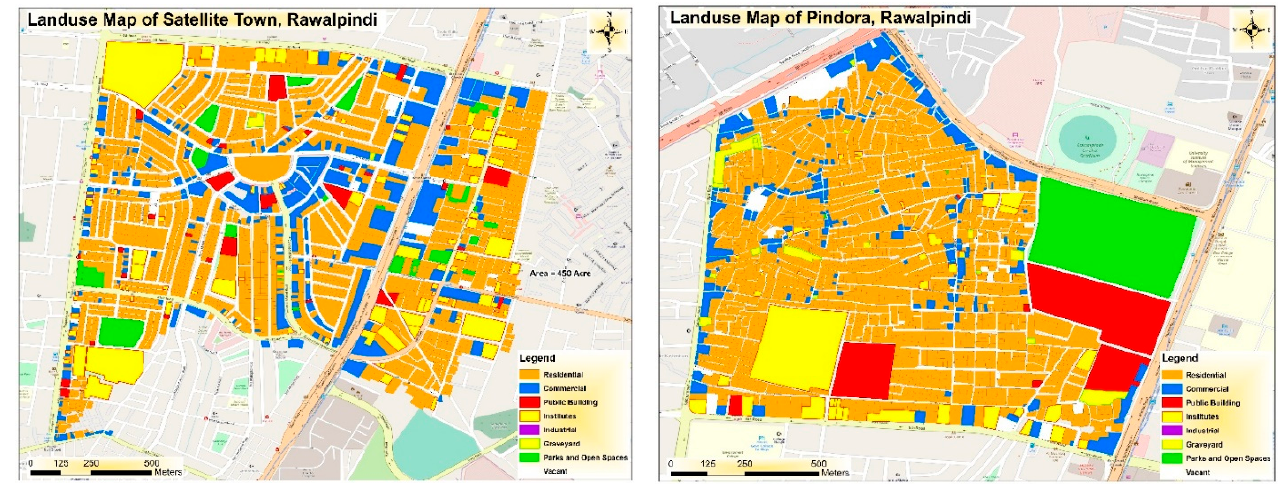
Figure 3. The two selected neighborhoods in Rawalpindi, [42].